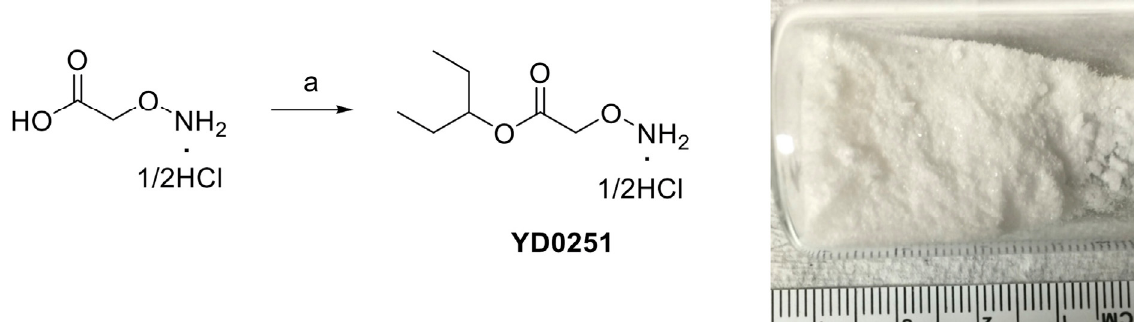
Figure 2. Streamlined synthesis of YD0251 suitable for scale-up at the gram to kilogram level. Reagents and conditions: (a) 3-pentanol, SOCl 2 , rt, 2 h, 100 ◦ C, 16